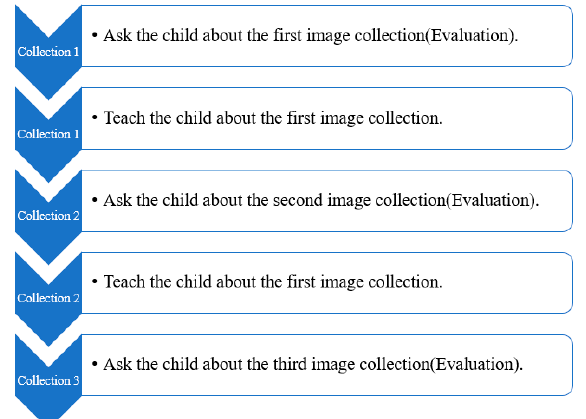
Figure 4. Experimental design